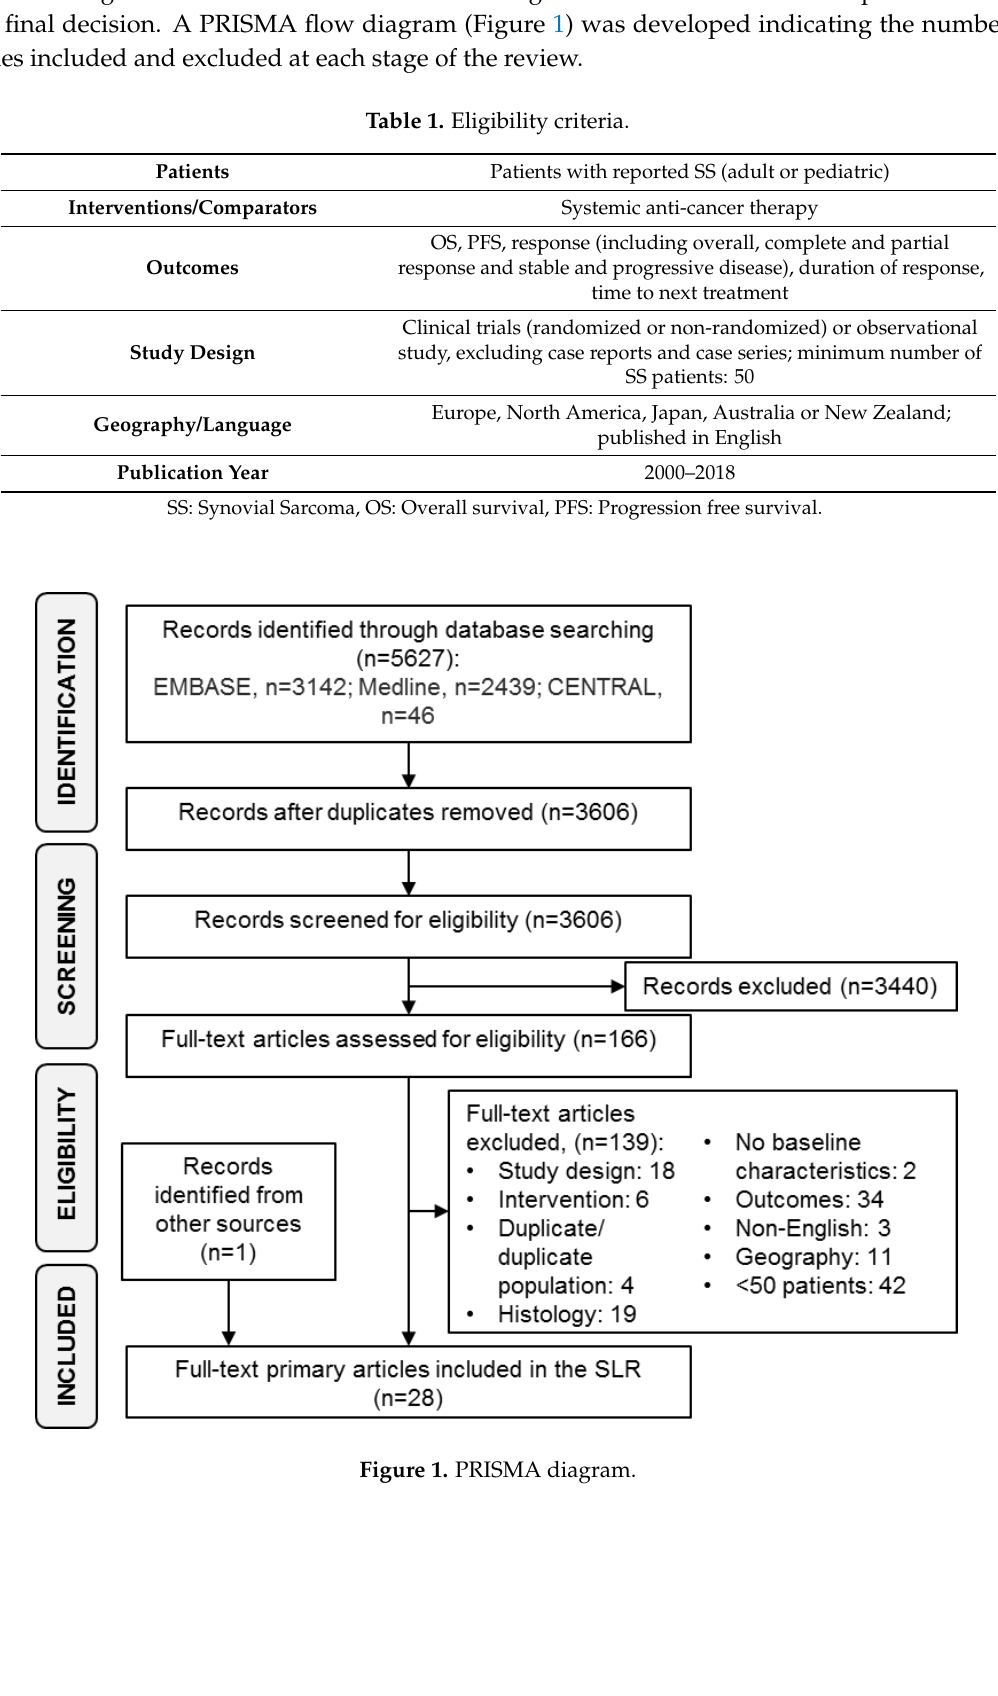
Table 1. Eligibility criteria.